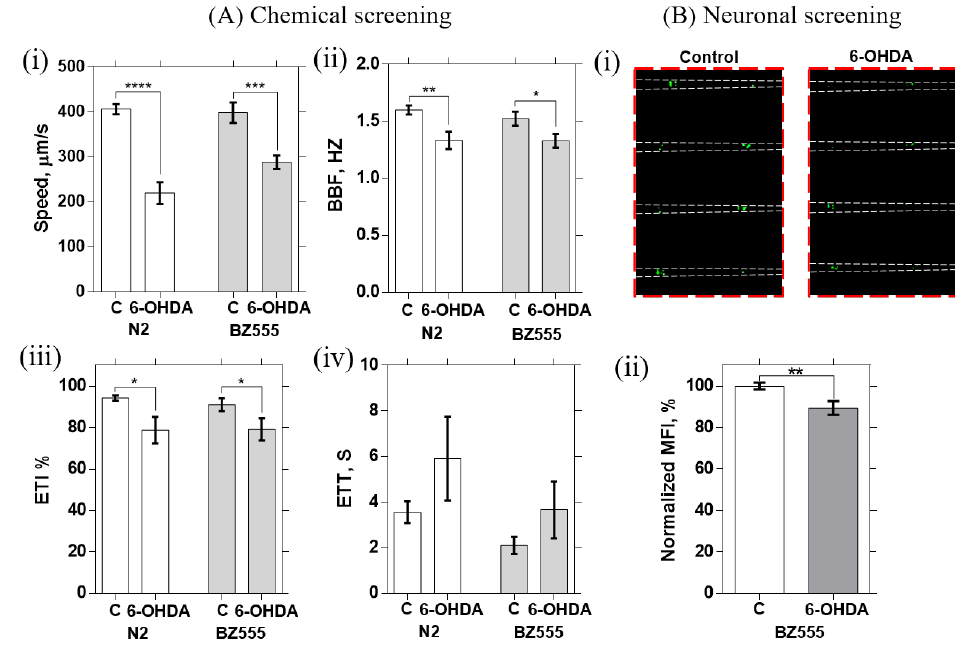
Figure 5. Application of the microfluidic device to chemical and neural screening at EF = 3.7 V/cm using N2 (wild-type) (N = 16/17 responders for control and N = 27/29 responders for exposed worms) and BZ555 strain (N = 19/20 responders for control and N = 24/29 responders for exposed worms) exposed to 250 µ M 6-OHDA (controls are shown by “C”). (i) Worm speed, (ii) body bend frequency (BBF), (iii) rlectrotaxis turning time (ETT), and (iv) electrotaxis time index (ETI). Error bars are SEM; *: p < 0.05; **: p < 0.01; ***: p < 0.001; ****: p <